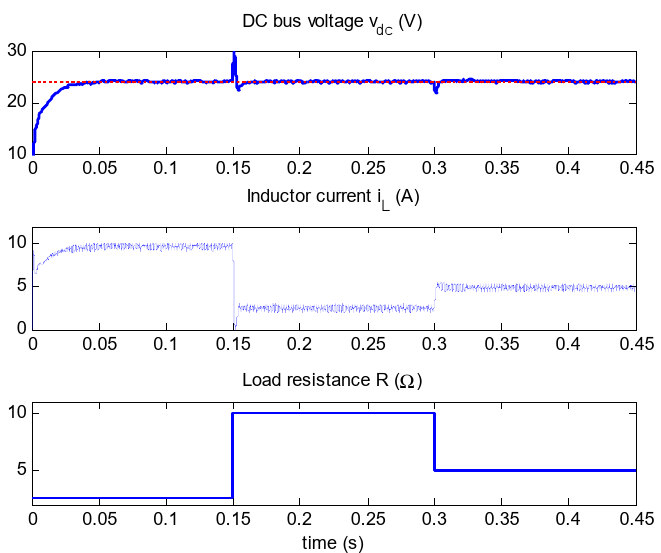
Figure 11. Robustness of the saturated controller in the presence of a load resitance uncertainty.